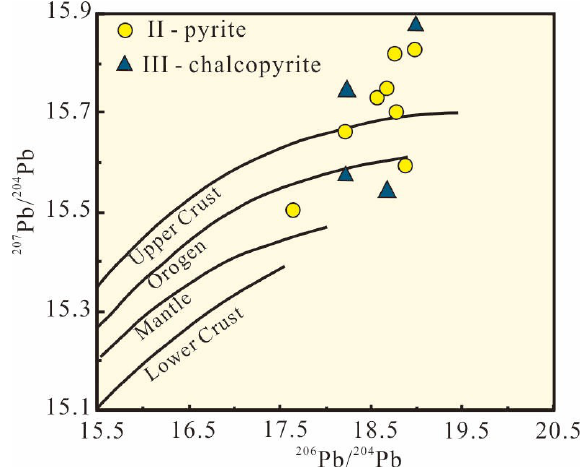
Figure 10 Figure 10. 207 Pb / 204 Pb vs. 206 Pb / 204 Pb diagram for ore sulfides from Xianglushan Fe-Cu deposit (modified from Liu et al.